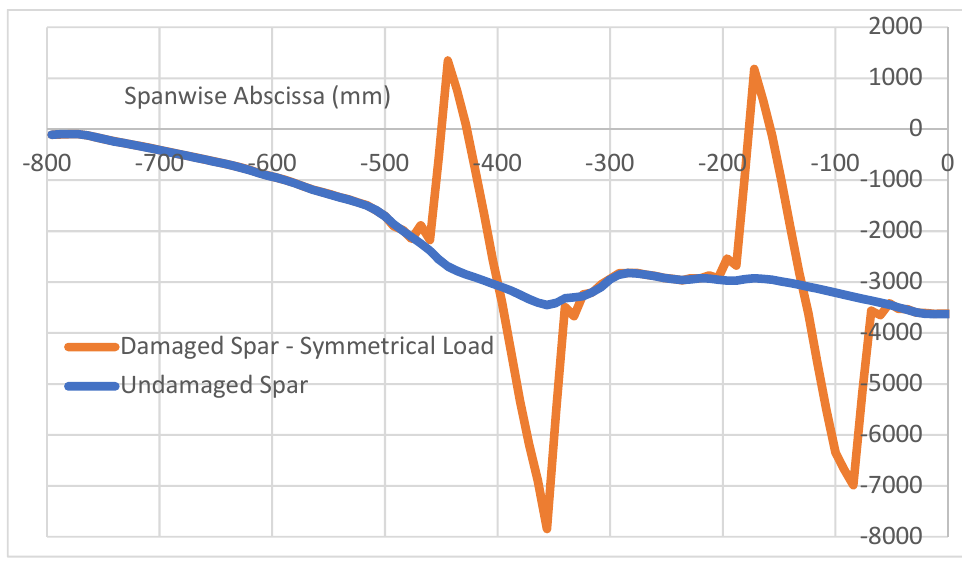
Figure 20. Schematic representation of the beam under investigation, half span. Visualization of the top caps of the longitudinal C-spar. Position of the flaws.